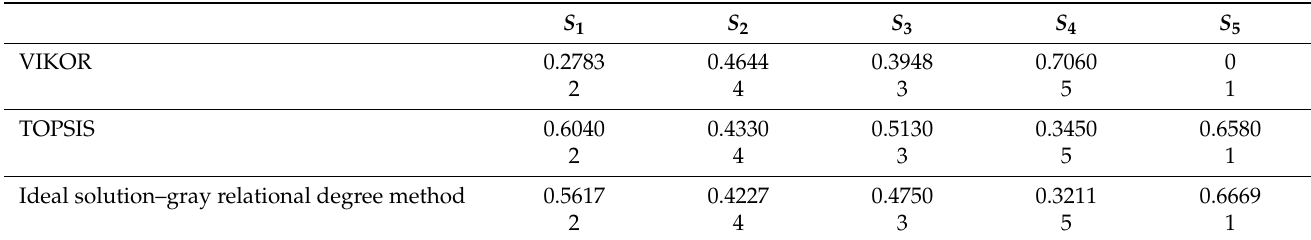
Table 4. Comparison of the evaluation results of various methods. S